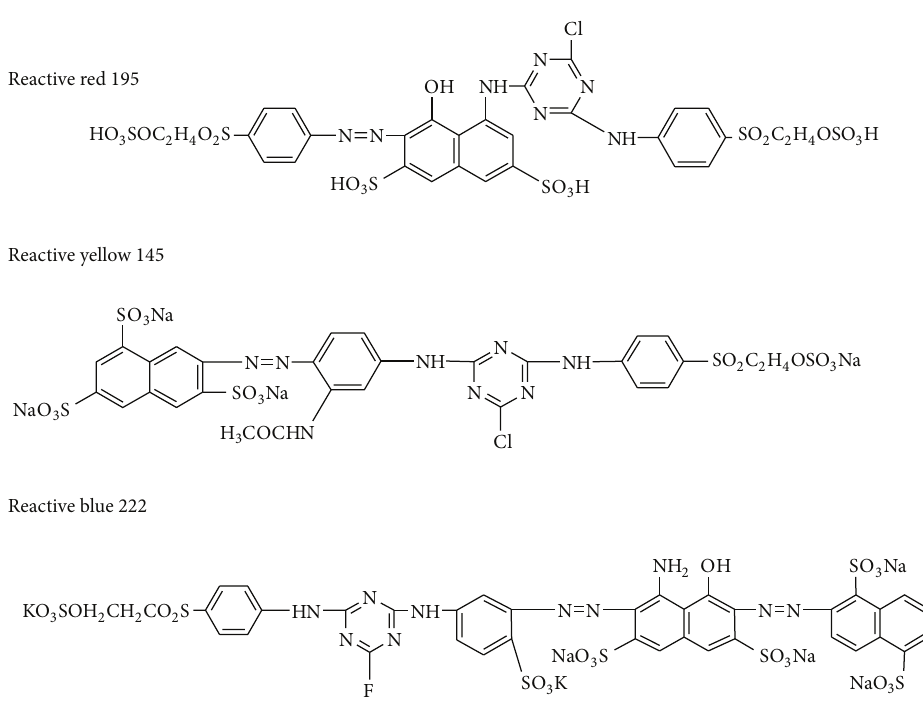
Scheme 1: Chemical structures of the three